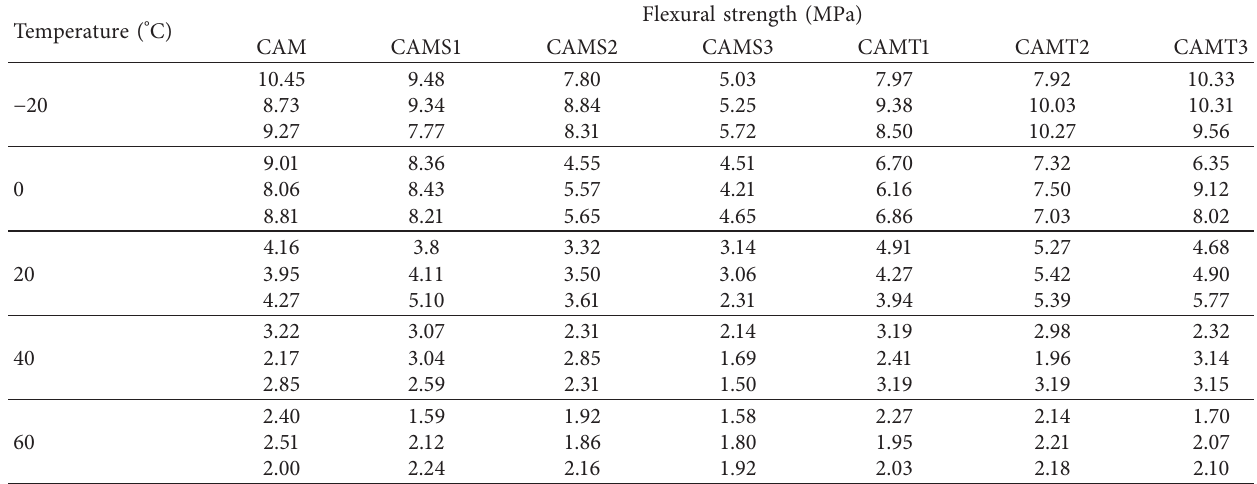
Table 5: Flexural strength of CAM with